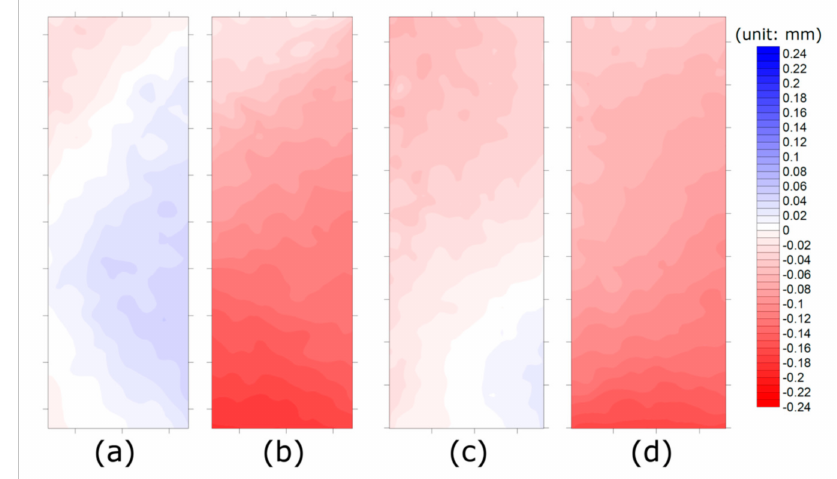
Figure 9. Displacement contours for the peak stage of stress–strain behavior (1.65–1.9% strain): ( a ) NC1 horizontal; ( b ) NC1 vertical; ( c ) OC1 horizontal; and ( d ) OC1